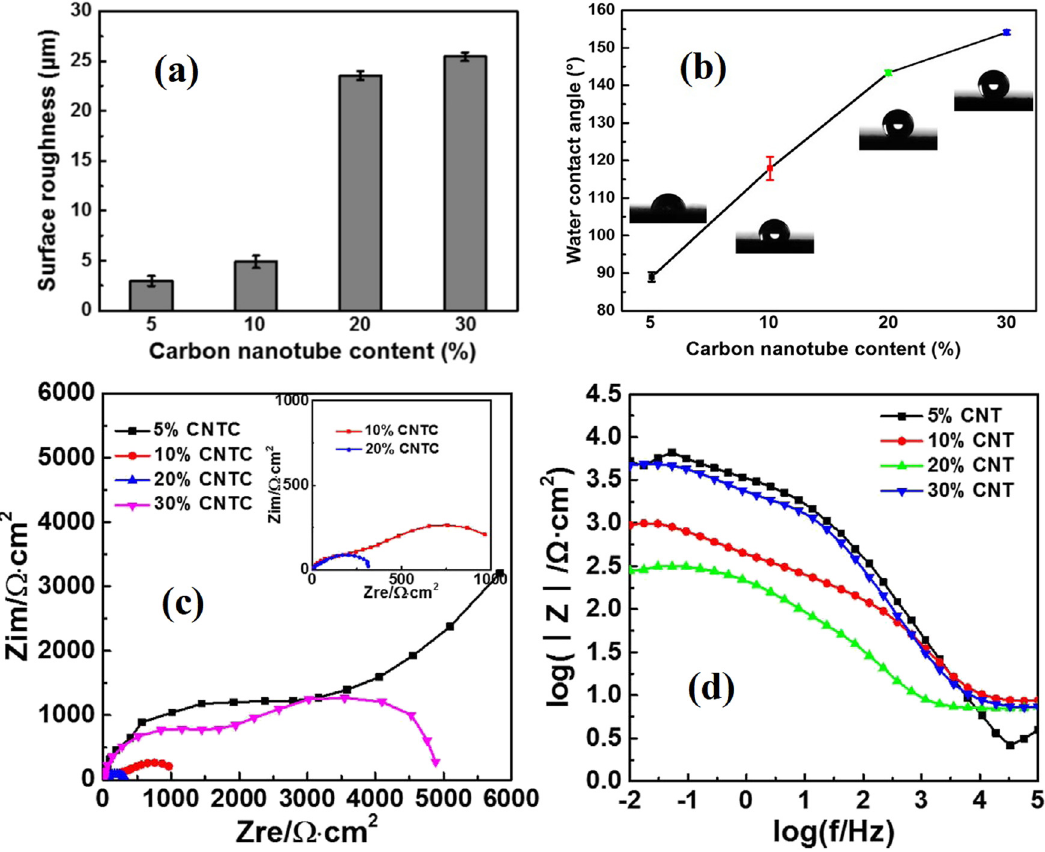
Figure 13: Evolution of ( a ) surface roughness and ( b ) CA of MWCNTs/EP coatings. ( c ) Nyquist and ( d ) Bode plots recorded in 3.5 wt% NaCl [ 155 ] . Reproduced with permission from ref. [ 155 ] ; © 2018 Elsevier